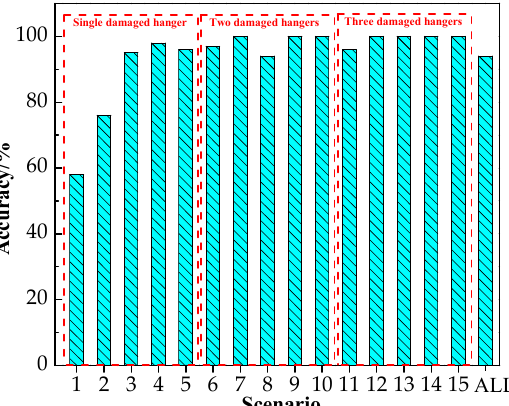
Figure 9. Accuracy of CNN-LSTM for damage localization under different scenarios.